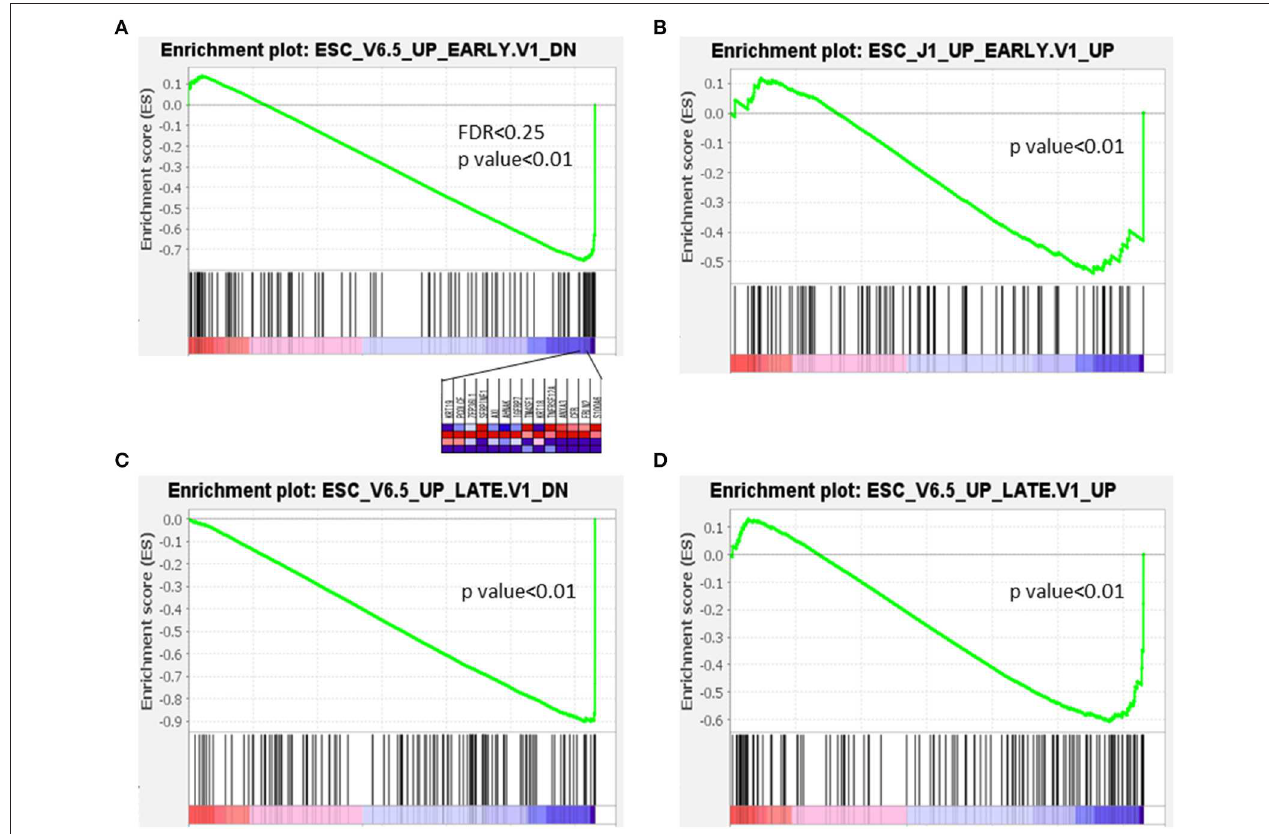
FIGURE 5 | Expression in PanIN derived from mouse PDA was negatively correlated with differentiation of embryoid bodies from mouse embryonic stem cells.